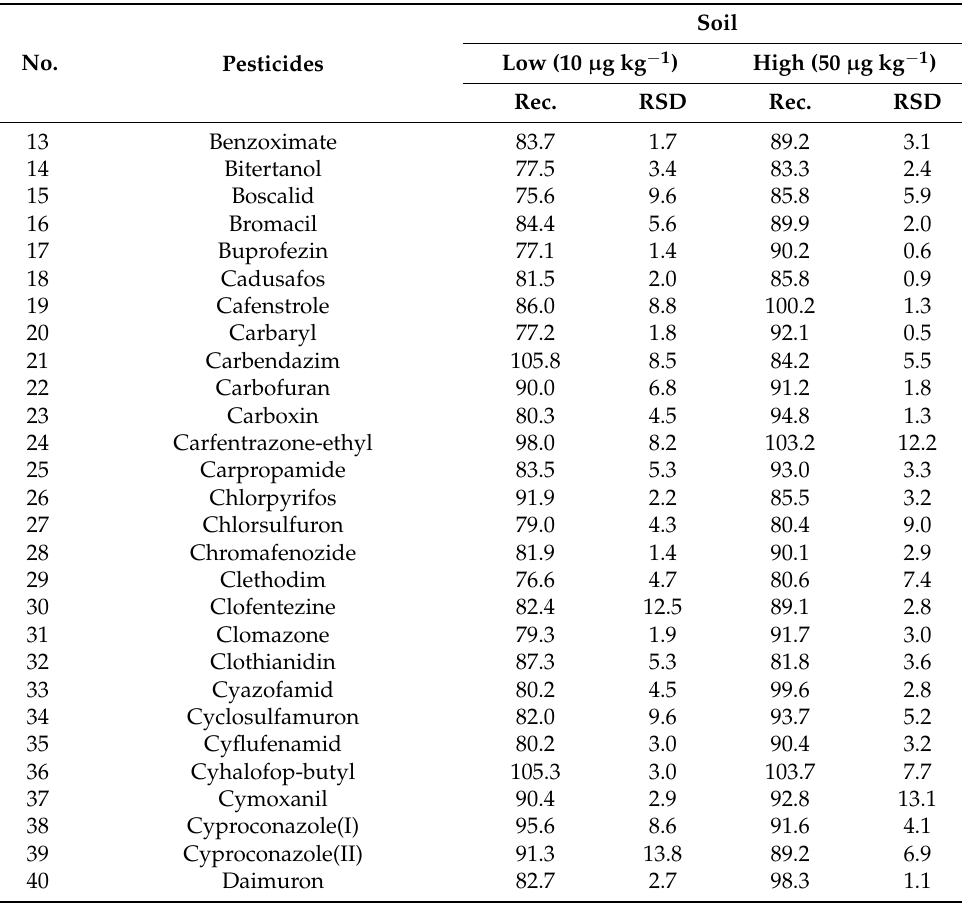
typed systemic fungicide that is absorbed by foliage and roots, and is translocated to